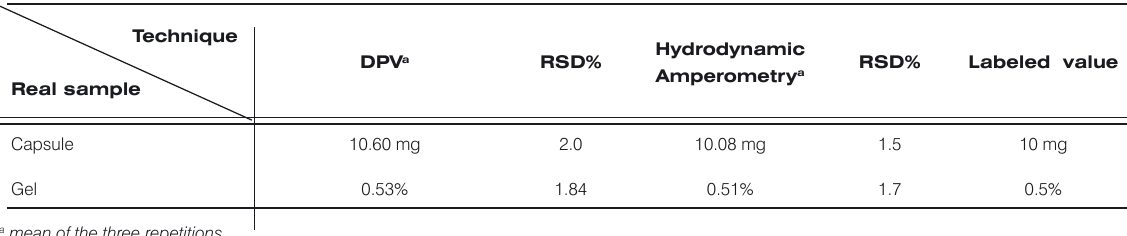
Table 2. Obtained recoveries by applying proposed method for determination of Piroxicam